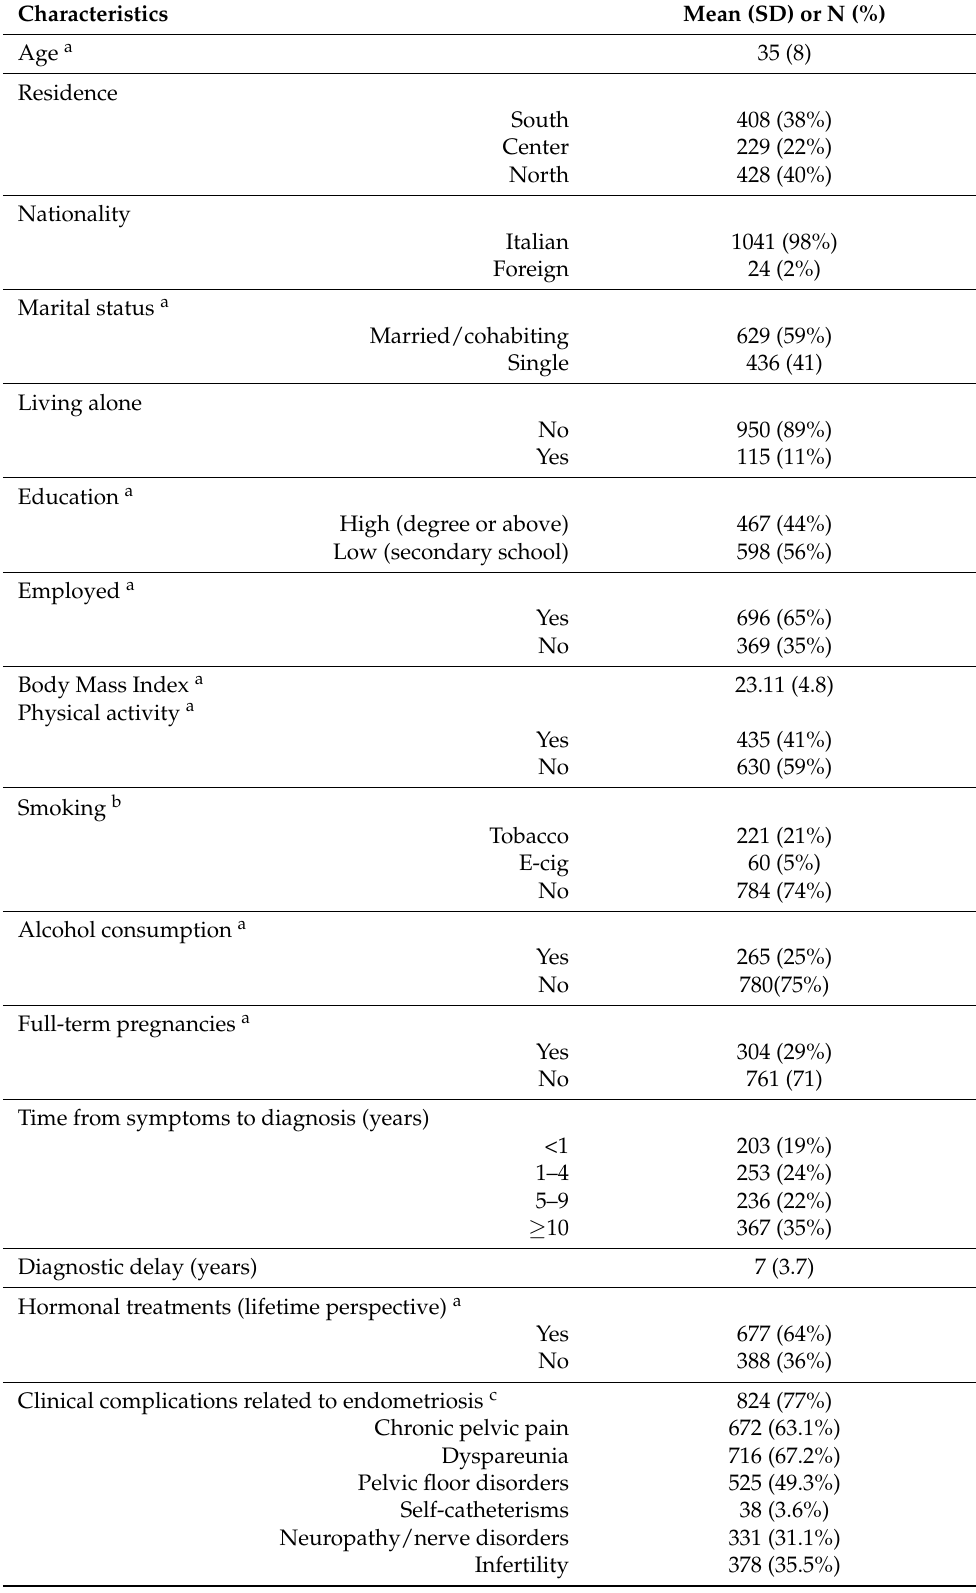
Table 1. Sample characteristics: socio-demographic and clinical data (All participants n .